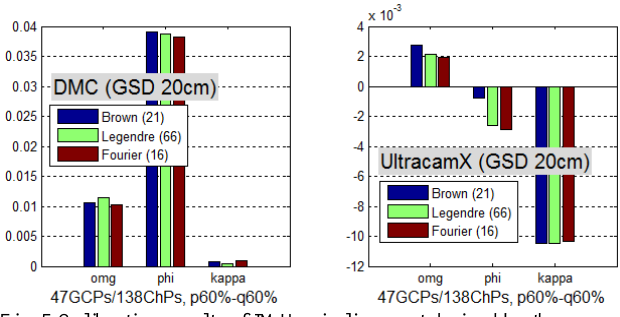
Fig. 5 Calibration results of IMU misalignment derived by three different APs in the blocks of DMC (left) and UltracamX (right) cameras (unit: gon)